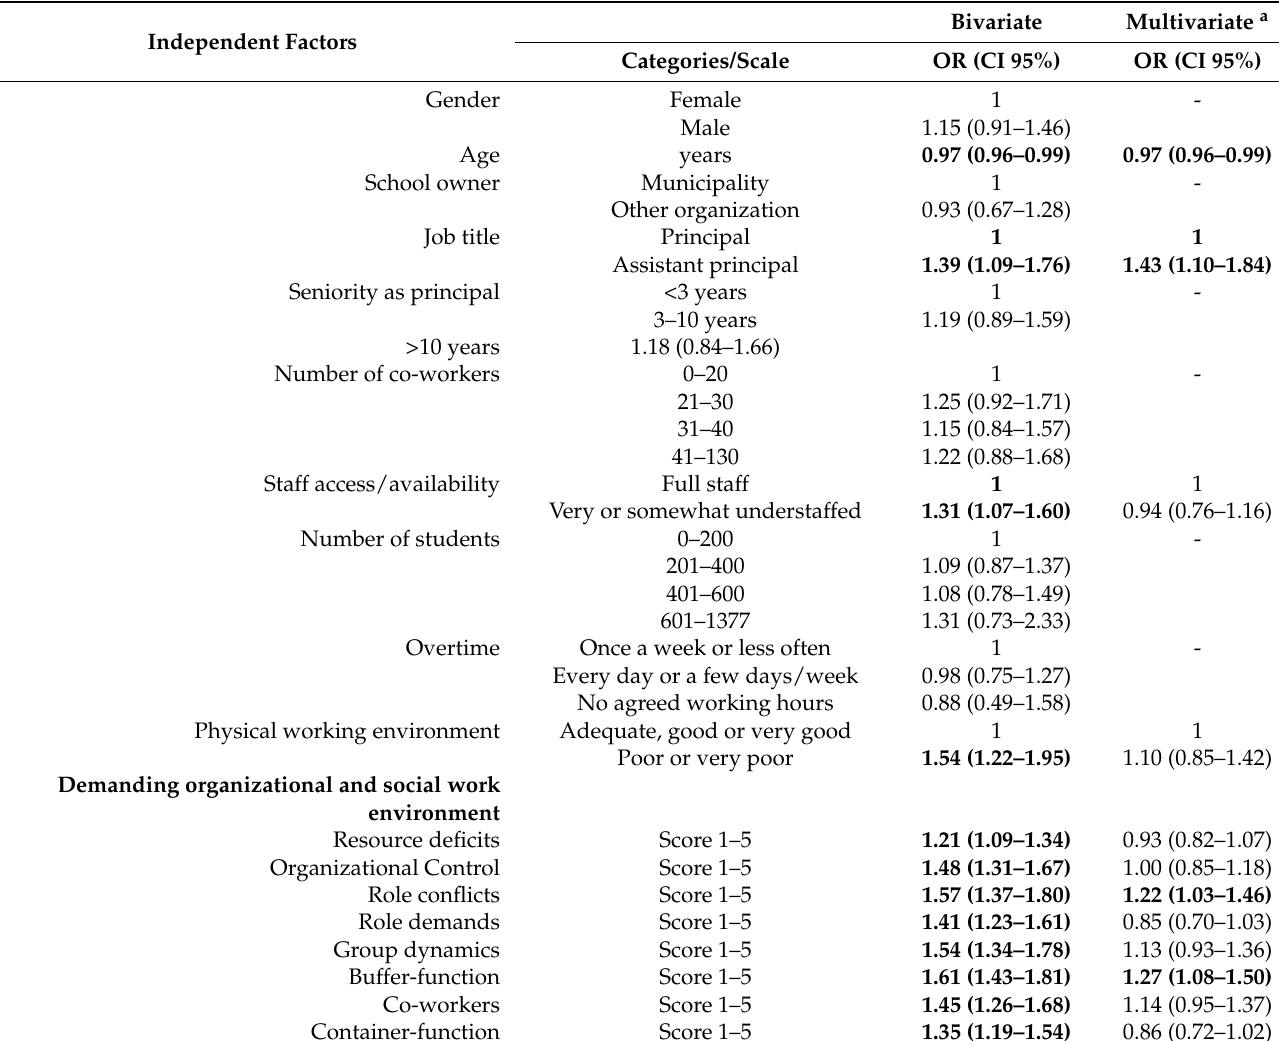
Table 2. Cross-sectional bivariate and multivariate binary logistic regression analysis between occupational factors, gender age, and signs of exhaustion and the dichotomous outcome of intention to change workplace (no vs. yes, probably/yes, definitely) in the total study sample, taking repeated assessments in the years 2018 (N = 984) and 2019 (N = 884) into account. Odds ratio (OR) and 95% confidence intervals (CI) are presented, which in continuous variables (GMSI and KEDS) are associated with a one-unit increase/decrease in mean score on the scale. Results in bold face are statistically significant. Independent